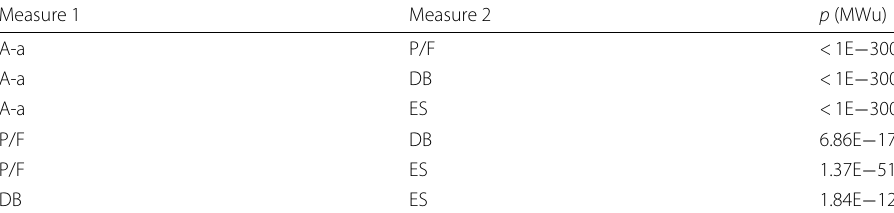
Table 1 Pairwise comparisons between errors in oxygenation measures in test set (Mann-Whitney U test, Bonferroni